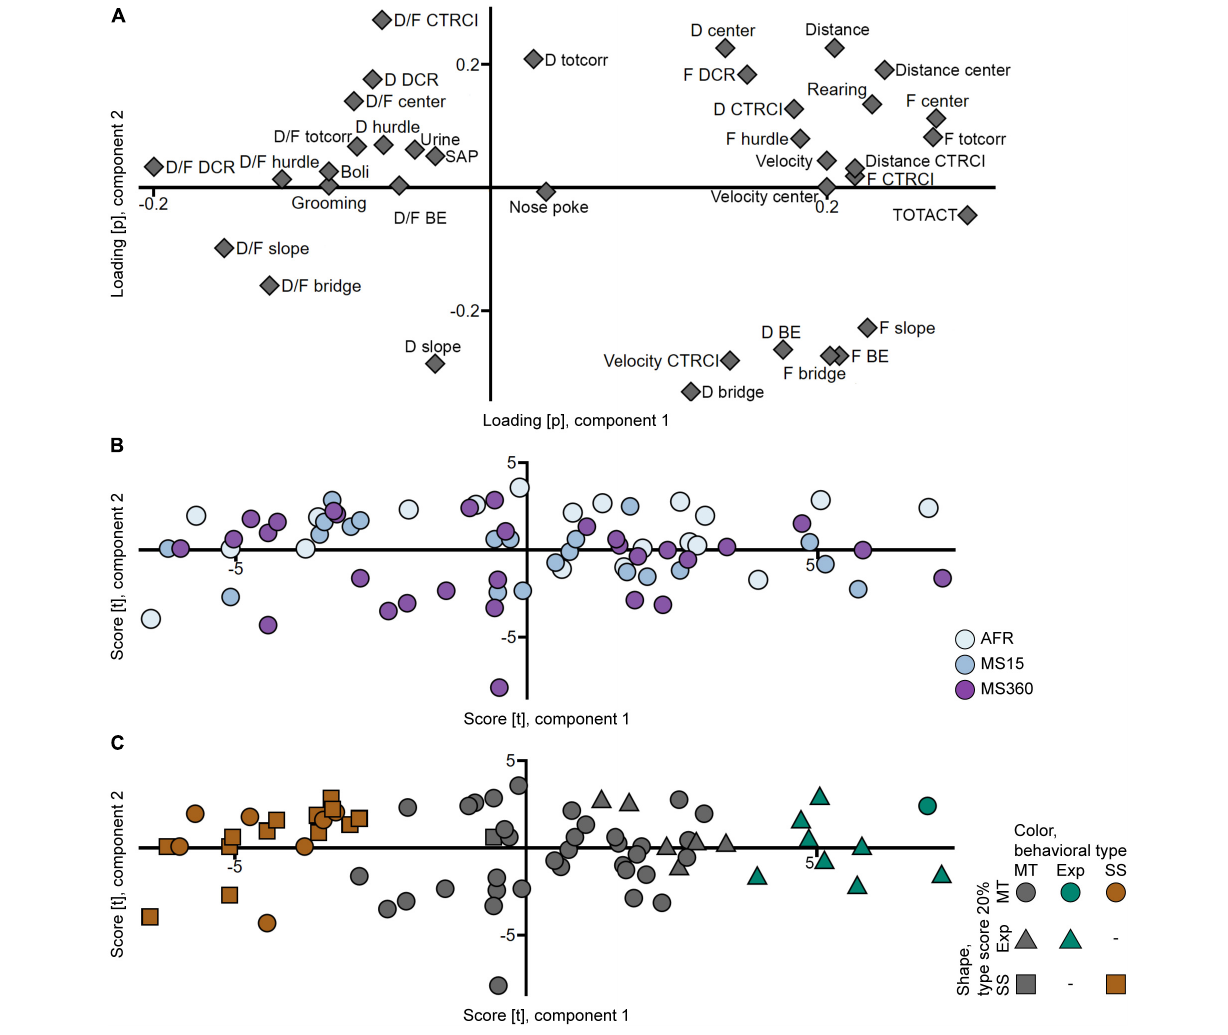
FIGURE 3 | Scatter plots of the (A) parameter loadings and (B,C) individual scores from the adolescent PCA ( n = 71, two components, R 2 X = 0.439, Q 2 = 0.314). (B) is colored according to rearing condition and (C) according to behavioral type, and the shapes show the top 20% of each type score (exploration and shelter seeking). AFR, animal facility reared; BE, bridge entrance; CTRCI, central circle; D, duration; DCR, dark corner room; D/F, duration per visit; Exp, Explorer/exploration; F, frequency; MS15, maternal separation 15 min; MS360, maternal separation 360 min; MT, Main type; SAP, stretched attend posture; SS, Shelter seeker/seeking; TOTACT, total activity; totcorr, total